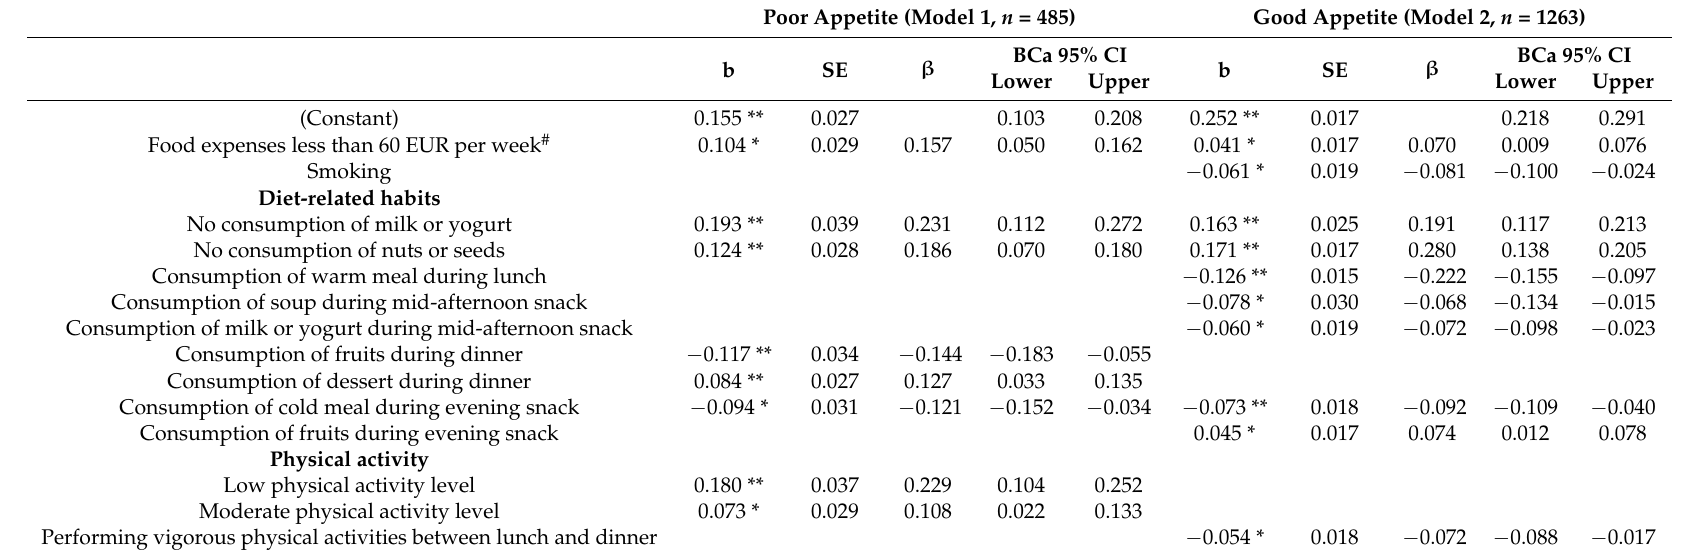
Table 7. Association between behavioural determinants and probability of having a protein intake lower than 1.0 g/kg adjusted BW/day stratified by appetite level in 1825 adults aged 65 years and older from five European